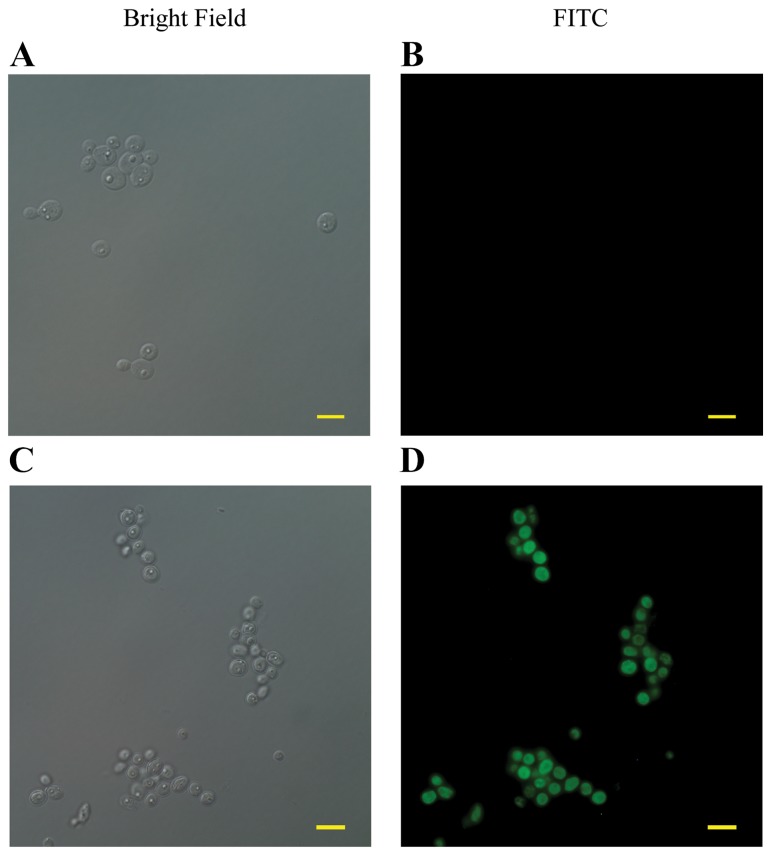
Effect of purpurin on DNA integrity (TUNEL assay).Representative fluorescent images showing the occurrence of DNA degradation in purpurin-treated C. dubliniensis biofilms captured by confocal microscope. A) Biofilms in the absence of purpurin (Bright Field). B) Biofilms in the absence of purpurin (FITC). C) Biofilms in the presence of purpurin (1 μg/ml) (Bright Field). D) Biofilms in the presence of purpurin (1 μg/ml) (FITC). Cells with damaged DNA emitted intense green fluorescence. The bar represents 50 µm.